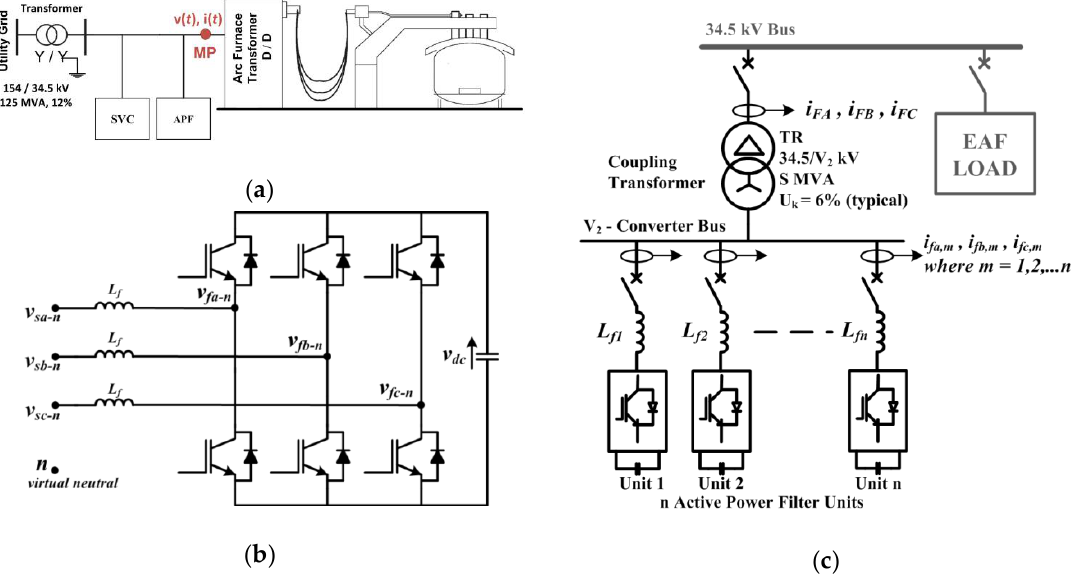
Figure 4. Proposed EAF system ( a ) block diagram including an APF and an SVC; ( b ) m APF units operating in parallel and connected to the grid via a coupling transformer; and ( c ) the three-phase three-wire two-level VSC converter for each APF